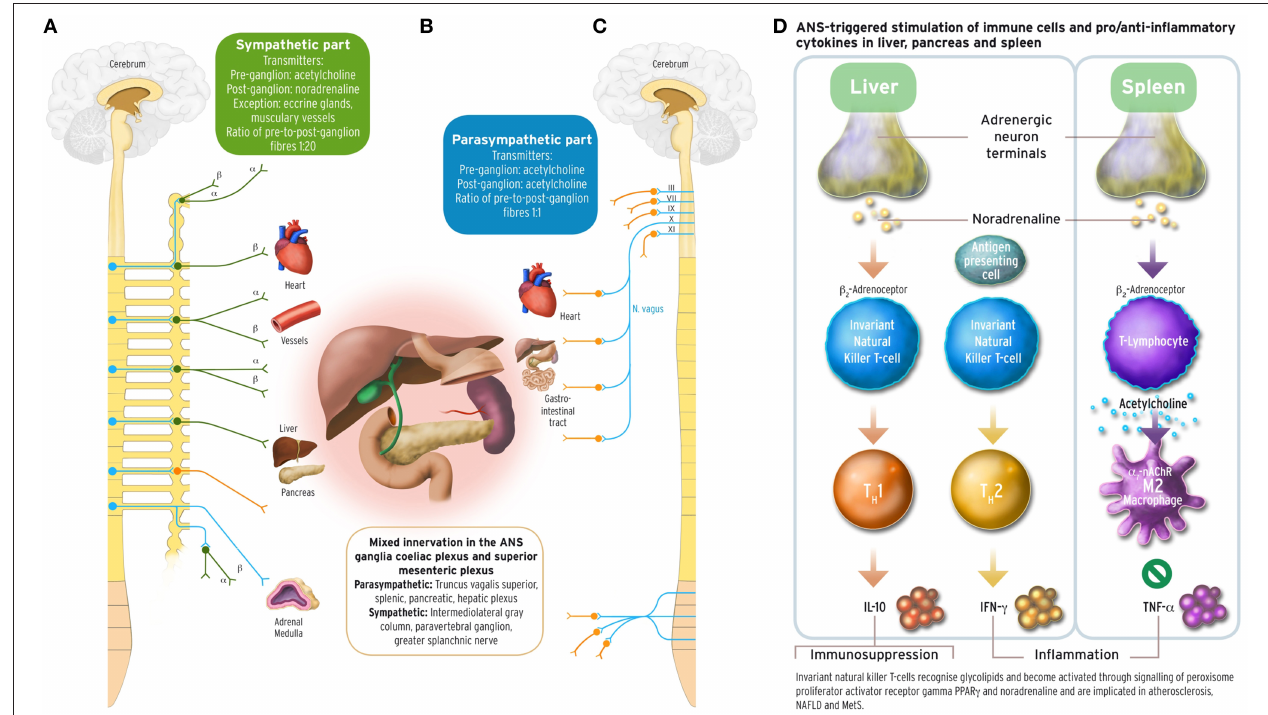
FIGURE 1 | Sympathetic and parasympathetic innervation of the coeliac and superior mesenteric plexus ganglia, and immune and cytokine mechanisms in cholinergic anti-inflammatory pathway. The acetylcholinergic anti-inflammatory pathway, the efferent arc of the inflammatory reflex (Section Inflammation and Arterial Rigidity; Tracey, 2002) converging in the spleen, has been discussed under the aspect of being a target for possible interventions counteracting autonomic imbalance in the metabolic syndrome related to chronic inflammation. Schematically depicted are innervations from the sympathetic and parasympathetic branches of the ANS, with their transmitters, into organ systems relevant for MetS. Left part panel (A) : efferent fibers in the sympathetic branch with adrenoceptor type. Middle part panel (B) : mixed sympathetic and vagal fiber connections into the coeliac and the superior mesenteric plexus ganglia innervating liver, pancreas and spleen. Right part panel (C) : efferent fibers in the parasympathetic branch of the ANS. The insert panel (D) to the outer right hand side illustrates schematically the role of vagus stimulation-derived, yet noradrenergic transmission into liver and spleen, and the acetylcholinergic transmission between CD4 + T helper cells and macrophages in the spleen. Vagus departs the brainstem as its cranial nerve X, and vagal efferent outflow regulates visceral organs by counterbalancing sympathoexcitation, inhibiting cytokine release, and safeguarding against inflammatory damage to liver, pancreas, spleen, lungs, or kidneys in endotoxaemic states. The outflow of the vagus nerve triggers adrenergic neurons in the coeliac ganglion innervating the spleen further to liver and pancreas. Vagal influence to spleen T lymphocytes stimulates the release of the neurotransmitter acetylcholine (ACh), and activation of the α 7 subunit of the nicotinic ACh receptor ( α 7 nAChR; Section Inflammation and Arterial Rigidity) expressed on cell membranes of splenic macrophages and other cytokine secreting cells. Vagal tone attenuates here production of the inflammatory response cytokine tumor necrosis factor alpha (TNF α ) reciprocally related to sympathoexcitation (Zhang et al., 2003; Kisiswa et al., 2013). In the liver, noradrenergic innervation signals hepatic innate natural killer T cells (iNKT) (Van Kaer et al., 2013) to exert systemic immunosuppression. Increasing the vagal tone there induces a shift from pro-inflammatory T helper cell type 1 (T H 1) cytokines such as interferon- γ (IFN- γ ) to anti-inflammatory T H 2-type cytokines, such as interleukin-10 (IL-10) (Tracey, 2007, 2009; Rosas-Ballina et al., 2008, 2011; Trakhtenberg and Goldberg, 2011). PVNH hypothalamic insulin promoter expressing neurons downregulate postprandial inflammation through cholinergic signaling in the spleen mediated by vagal outflow to the spleen, whereas vagotomy results in T2DM (Carvalheira et al., 2014; Wang L. et al., 2014). Vagus stimulation approaches for increasing vagal tone would therefore aim to counterbalance prolonged sympathoexcitation in MetS by supporting parasympathetic output. These could comprise, but are not limited to,